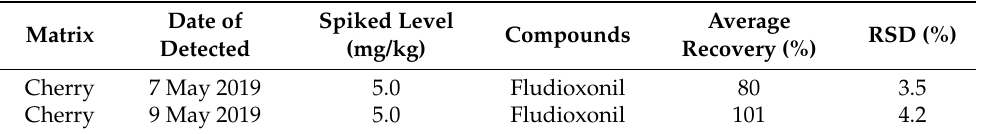
Table 4. Quality control (QC) of real sample detection.